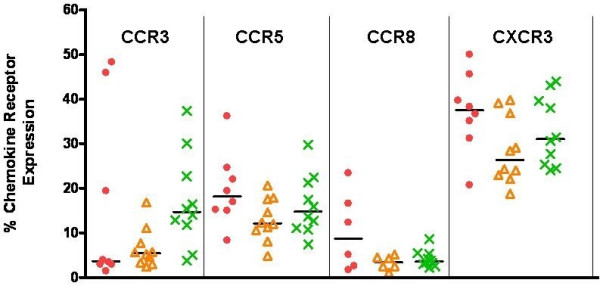
Percentage chemokine receptor positive memory T helper cells day 0. Percentage CCR3+, CCR5+, CCR8+ and CXCR3+ memory Th cells from allergic (dots), asymptomatically sensitized (triangles) and healthy control (crosses) individuals on day 0 immediate ex vivo. - = median value. n = 10 for the healthy controls, n = 10 for the asymptomatically sensitized and n = 8 for the allergic individuals except for CCR8 where n = 6 for the asymptomatically sensitized and allergic individuals. 10.000 PBMCs were acquired for the analysis. Isotype control cut-off values were set to >98%. Samples were run in monocates. For experimental design and analysis see Methods.